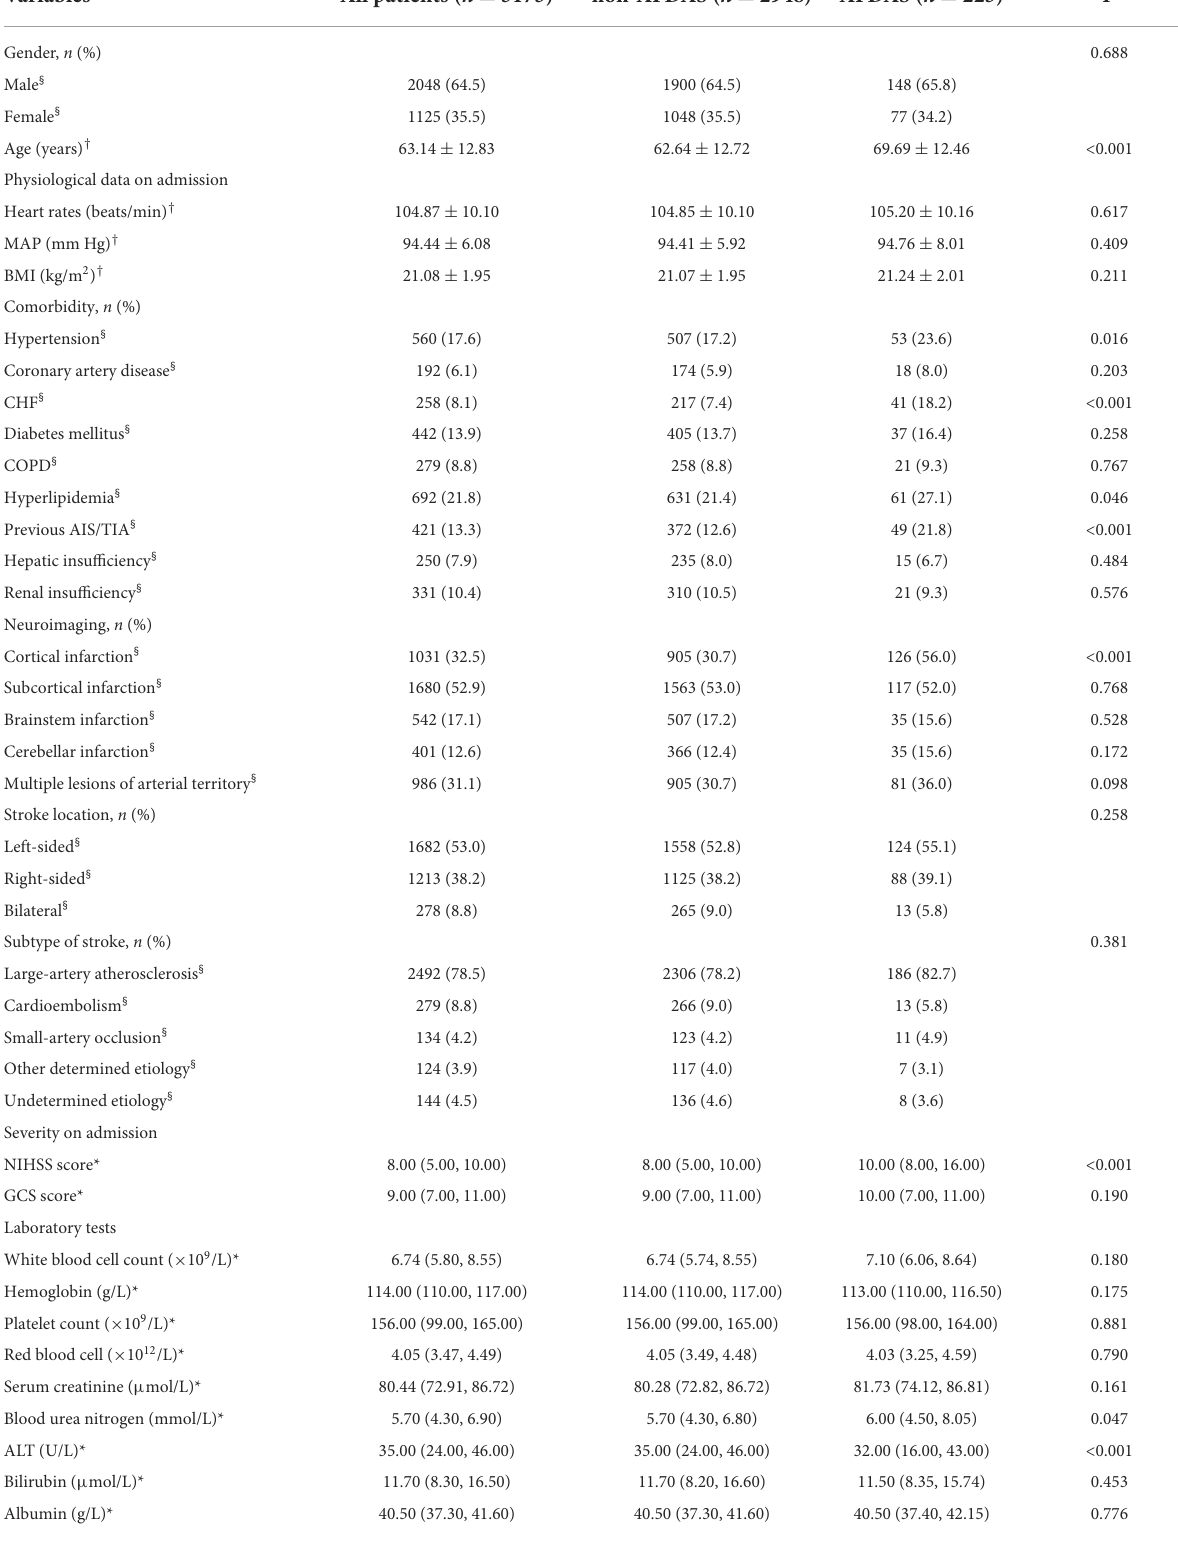
TABLE 1 Baseline characteristics of patients with non-AFDAS and AFDAS in training